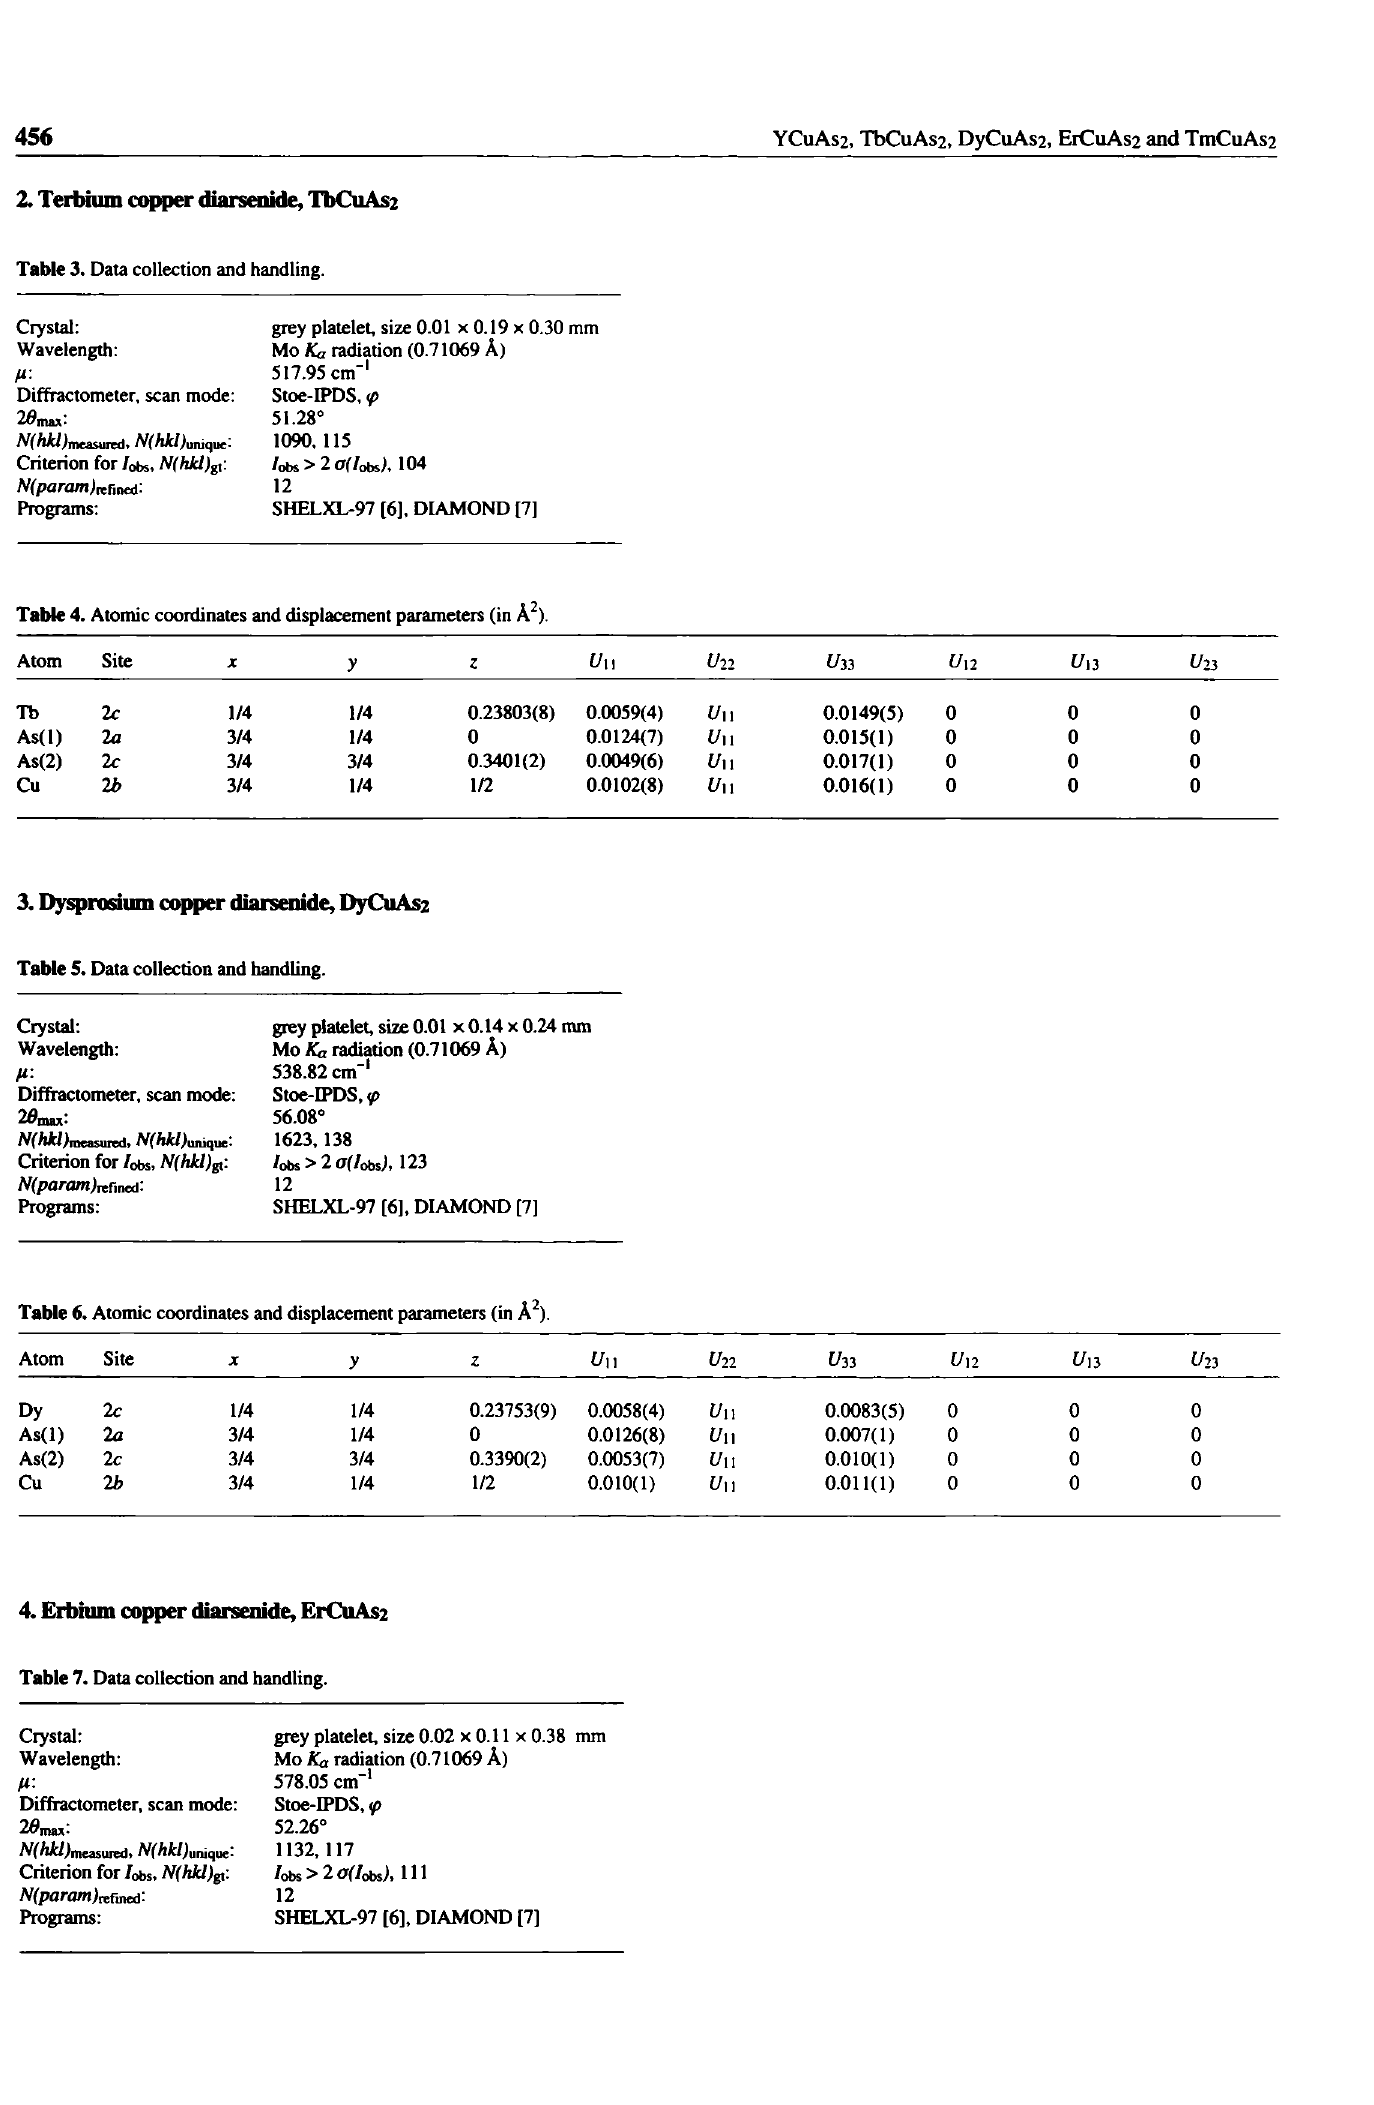
Table 7. Data collection and